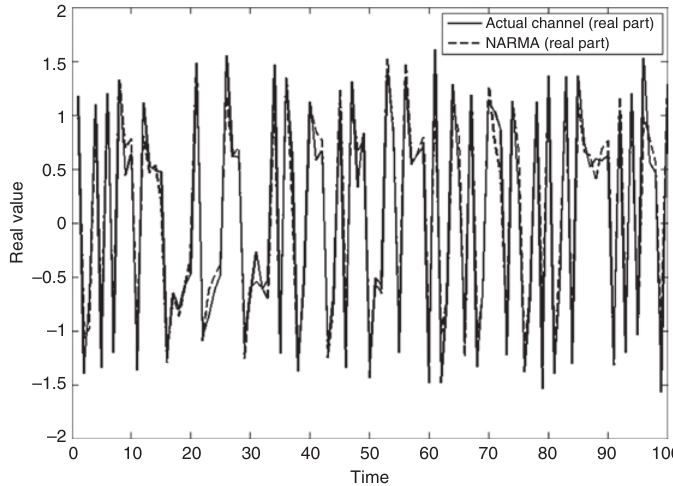
Figure 7: Channel Gain Plot (Real) for Case 1.